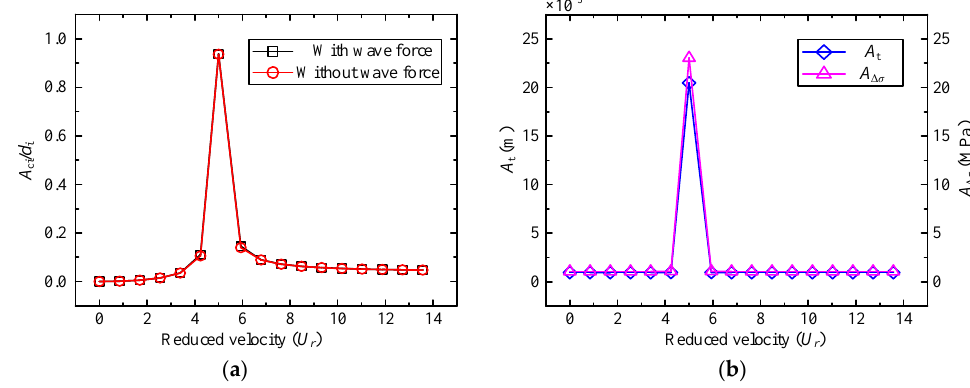
Figure 7. SFT structural response under different current velocity (frozen parameters: H = 8.2 m, T = 10.8 s, gravity-buoyance ratio (GBR) = 0.65 and inclined mooring angle (IMA) = 90°): ( a ) normalized maximum amplitude of the cable A ci / d i ; ( b ) maximum vibration amplitude of the tube A t , and maximum stress variation in the cables A Δ σ .